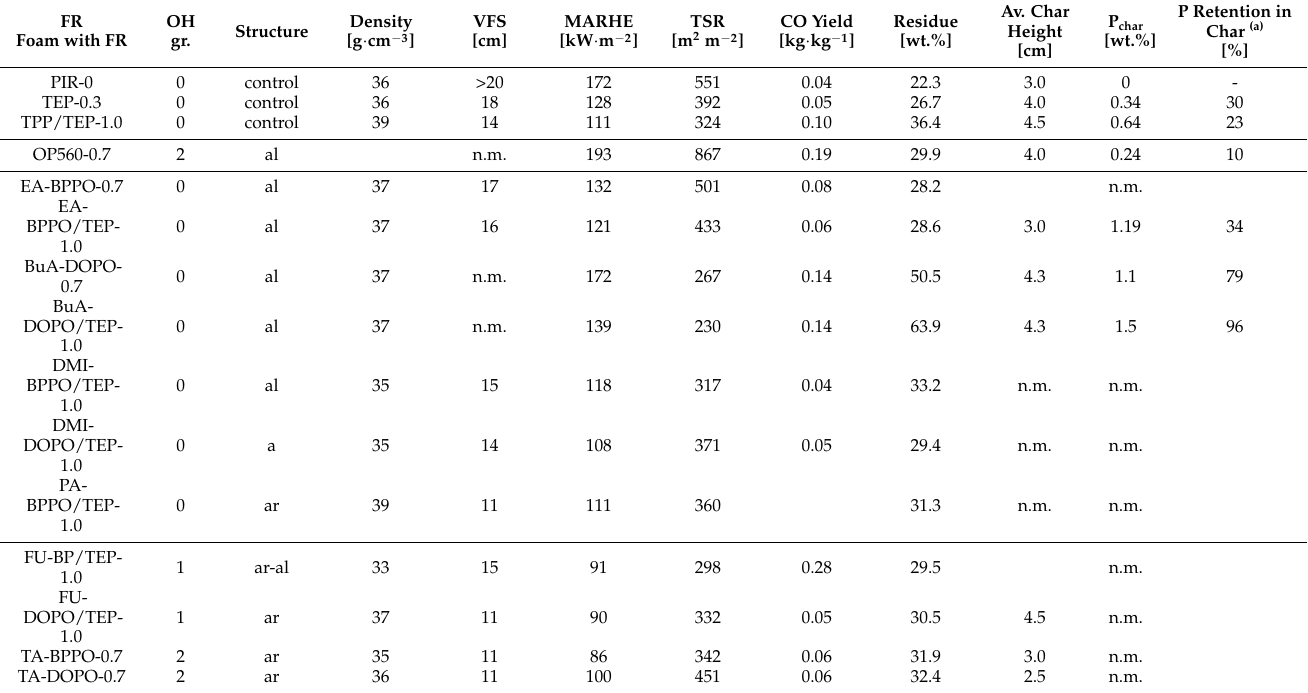
Table 7. Summary of fire-relevant parameters and chars remaining after cone calorimeter tests of the closed-cell PIR foams ( WA V < 20% )